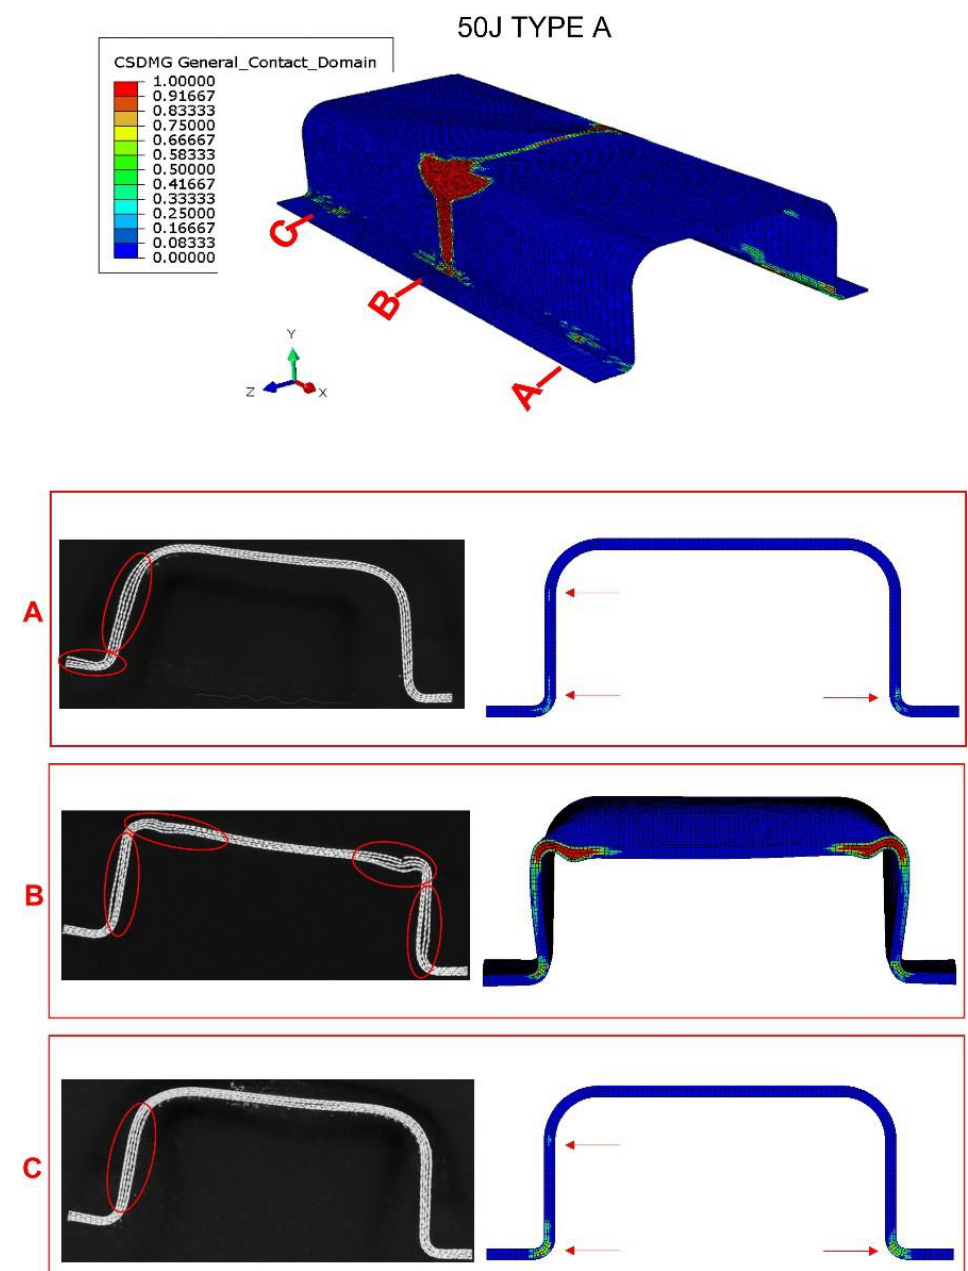
Figure 9. Tomography of bumper beam type A, impact energy of 50 J; comparison with numerical results. Observation of the interlaminar failure in the ends of the beam (sections A and C) and the center of impact (section B). The red arrows in the numerical screenshot point the appearance of failure in sections A and C.